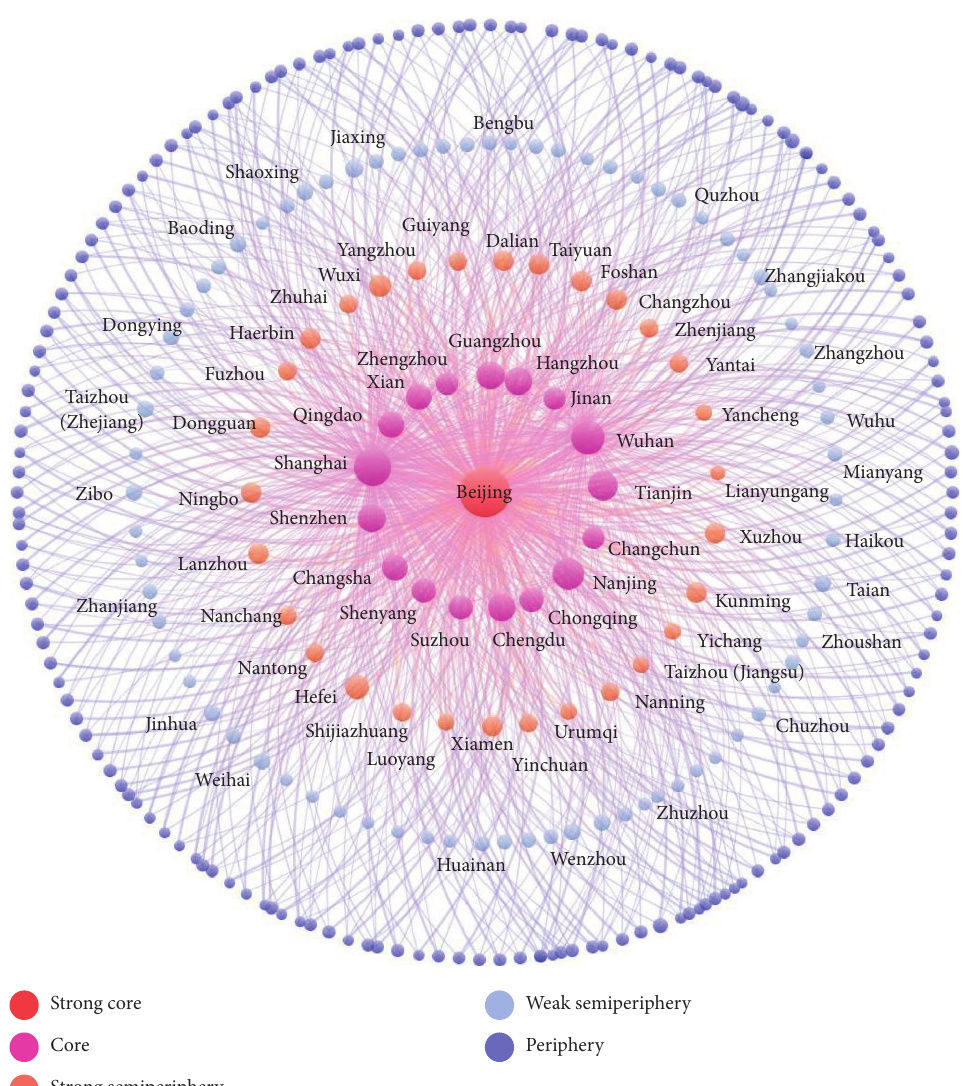
Figure 3: Hierarchical structure diagram of China’s intercity innovation